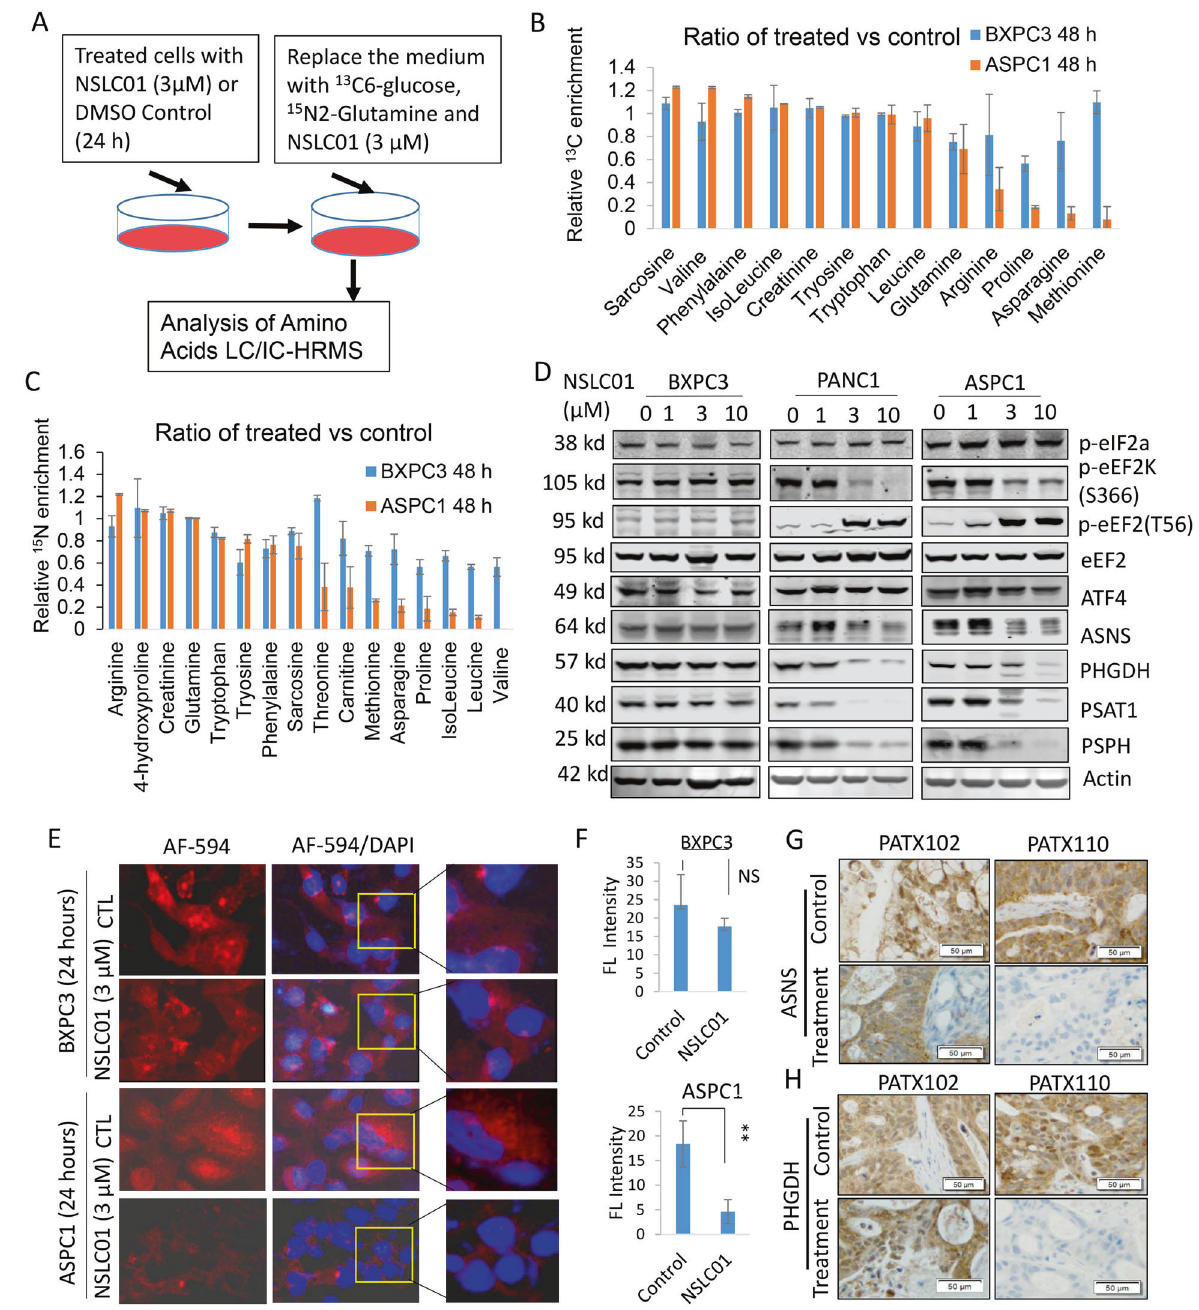
Fig. 5 NSLC01 inhibits the asparagine de novo synthesis pathway by targeting protein translation. A Experimental fl ow for the metabolic fl ux assay: BXPC3 (resistant to NSLC01) and ASPC1 (sensitive to NSLC01) were treated with NSC or DMSO for 24 h; cell medium was replaced with fresh medium supplemented with 13 C-glucose, 15 N2-glutamine, and NSLC01 (3 µM) for an additional 24 h; and analysis of amino acids was performed using liquid chromatography/high-resolution mass spectrometry. B , C The relative 13 C ( B ) and 15 N ( C ) enrichment ratios of metabolites with detectable 13 C or 15 N enrichment were calculated using the percentage of 13 C-labeled or 15 N-labeled metabolite in NSLC01- treated cells compared with those in control-treated cells. Metabolites without detectable 13 C or 15 N enrichment are not shown. D Western blot analysis of the key molecules in protein translation and, asparagine and serine synthesis pathways. E Protein synthesis assay using Click-It HPG kits: cells were treated with NSLC01 (3 µM) or control for 48 h, and nascent protein synthesis was analyzed with Click-It HPG Alexa Fluor protein synthesis assay kits. Red color indicates nascent synthesized proteins. F Quanti fi cations of fl uorescence inensity. G , H Immunohistochemistry staining of asparagine ASNS and PHGDH, respectively, in tumor specimens after